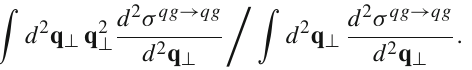
Fig. 3 The zeroth order in opacity contribution to the amplitude for leading order momentum